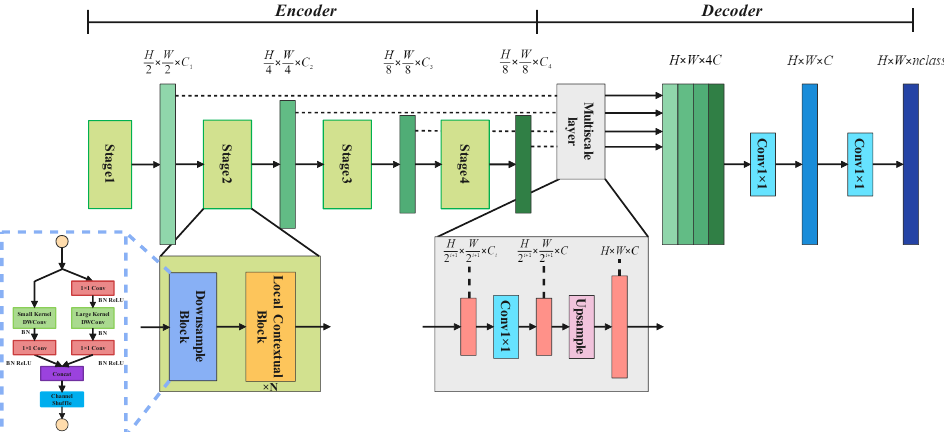
Figure 3. The overall architecture of the proposed network, which consists of two main modules. The CNN encoder extractd details and semantic features, and the decoder fuses the multi-scale features. The specific module parameters of the encoder are shown in Table 1.